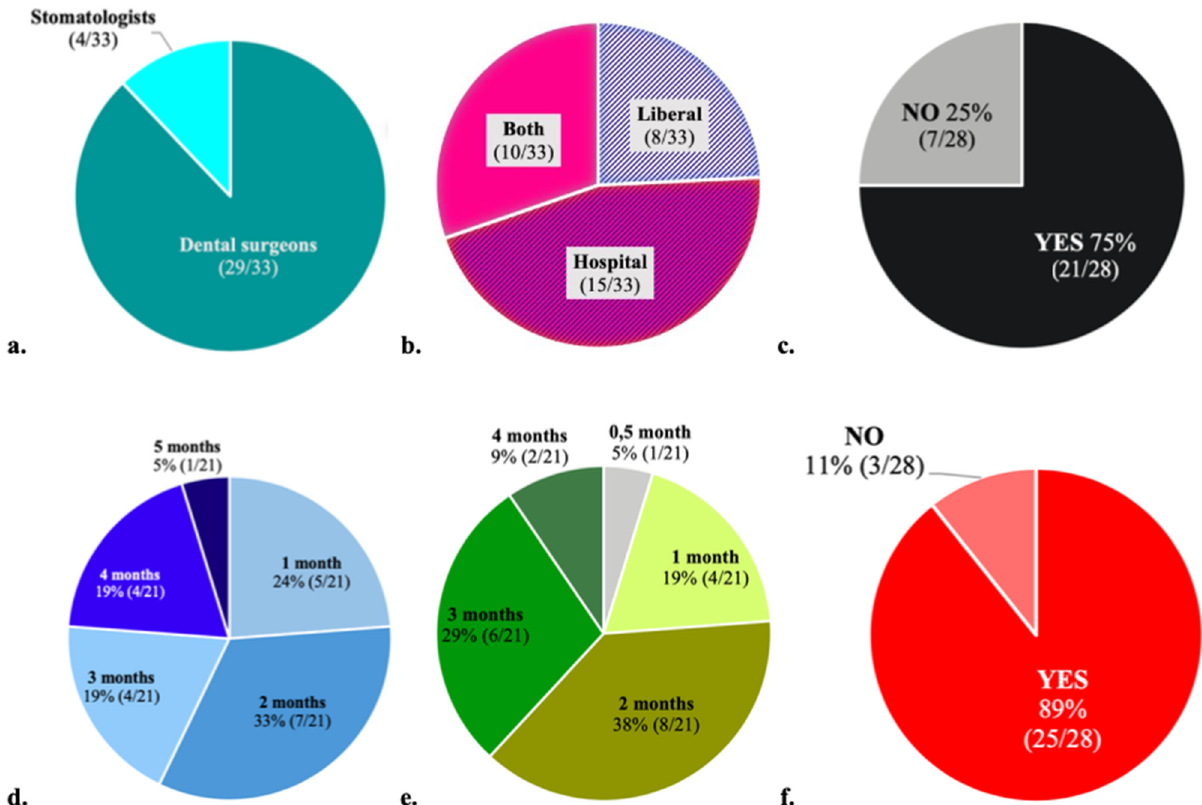
Fig. 2. (a to f): Results: a. Profession; b. Practice; c. Do you stop denosumab before having a dental extraction?; d. How long do you wait between stopping denosumab and dental extraction?; e. How long do you wait between dental extraction and reintroducing denosumab?; f. Do you modify your surgical procedure during extraction in these patients?